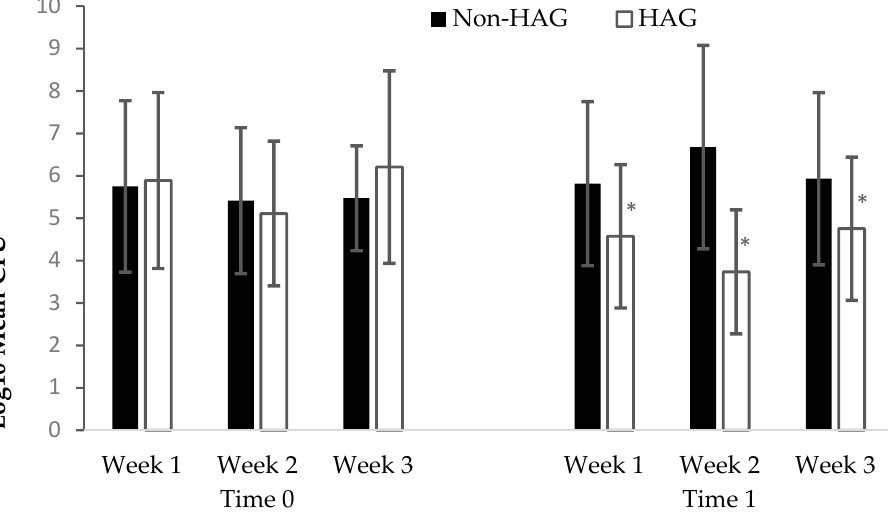
Figure 1. Recovery of bacteria from the hands of volunteers according to the use of alcohol-based gel (HAG). Values are expressed as log 10 mean CFU of 5 days a week for 3 weeks for left and right hands. Error bars indicate 95% confidence interval. Non-HAG: volunteers who did not use alcohol-based gel; HAG: volunteers who used alcohol-based gel. A statistically significant decrease in the counts (as log 10 CFU) obtained each week between Time 1 and Time 0 according to Friedman’s test is denoted by an asterisk ( p < 0.05).